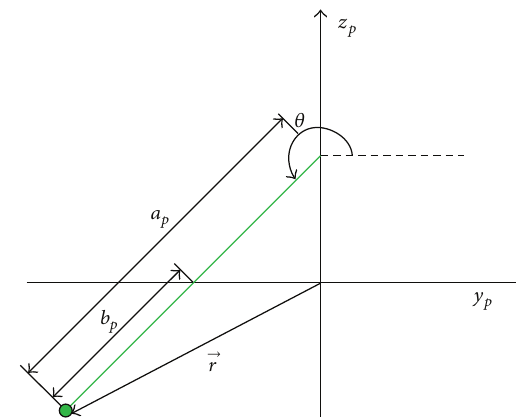
Figure 1: Schematic diagram for the motion of the trammel pendu- lum.